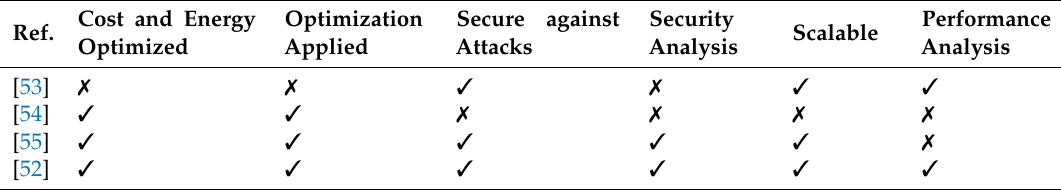
Table 3. Comparison of state-of-the-art research papers on energy trading in Electric vehicles (EVs) using